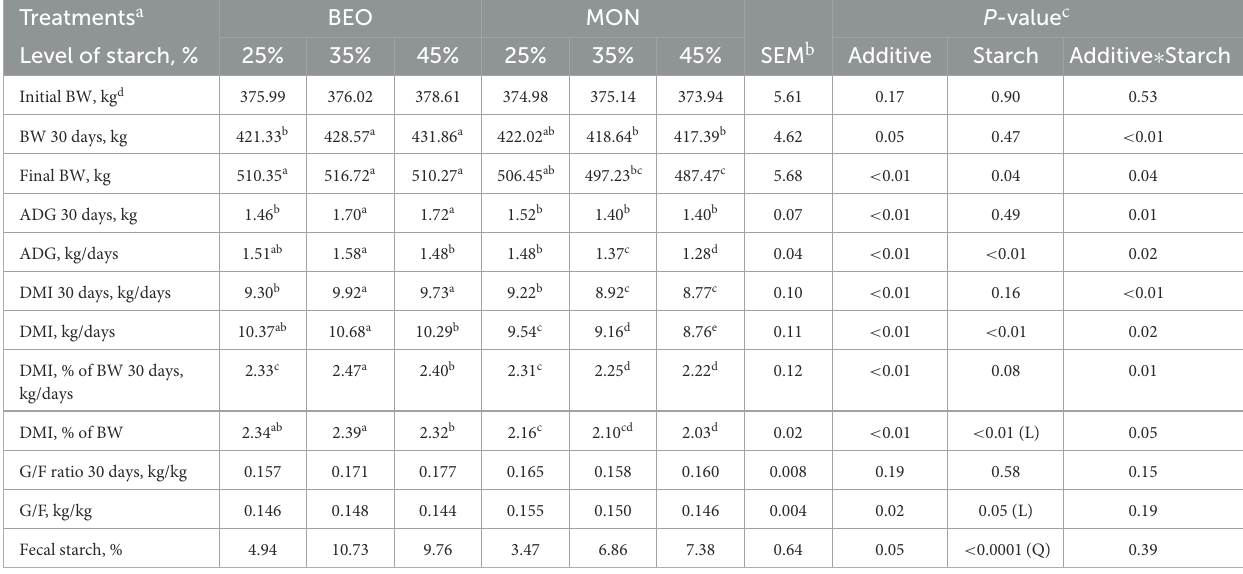
TABLE 2 Levels of starch associated with a blend of essential oils or sodium monensin on feedlot performance of Nellore yearling bulls. Treatments a BEO MON P- value c Level of starch, % 25% 35% 45% 25% 35% 45% SEM b Additive Starch Additive ∗ Starch Initial BW, kg d